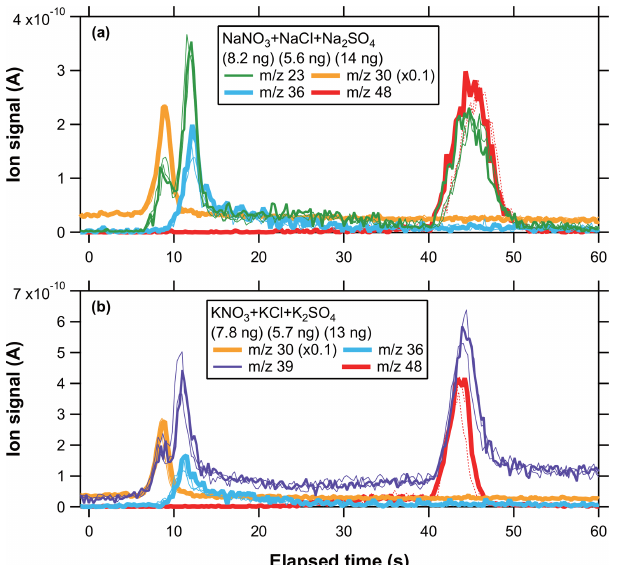
Figure 4. Temporal profiles of ion signals originating from an inter- nal mixture of (a) SN + SC + SS and (b) PN + PC + PS particles. The ion signals at m/z 30 were scaled by a factor of 0.1 for clar- ity of the presentation. The thin and dashed lines represent repeated measurement data normalized to the mass loadings of the main data (the thick lines).